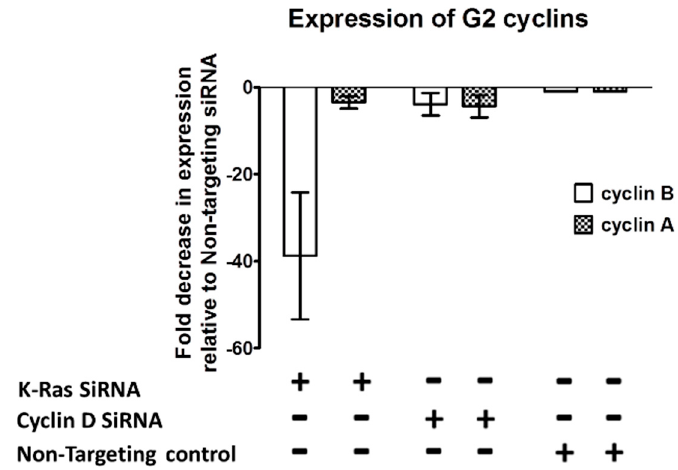
Figure 5. Effect of K-Ras depletion on G2 cyclin transcription. Graph showing an example of the decrease observed in G2 cyclin transcript when K-Ras or cyclin D is depleted. Cyclin B transcript levels after depletion with K-Ras are significantly lower than in non-targeting controls and after depletion with cyclin D ( p < 0.001, Mann–Whitney U test, standard deviation used as error bar). Cyclin A levels are also significantly lower after depletion of K-Ras than with no depletion; however, there was an equivalent decrease after cyclin D depletion.